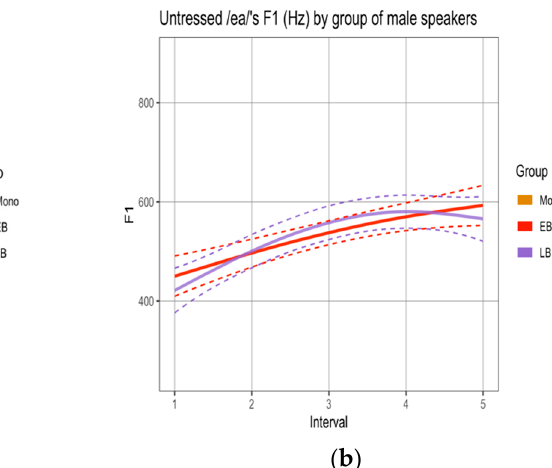
Figure A2. SSANOVAs for female fromant trajectories across five intervals within the sequences ( a ) /ae/ (F2); ( b ) /ea/ (F1); ( c ) /ea/ (F2); ( d ) /oe/ (F1); and ( e ) /oe/ (F2) produced by each group of speakers (M, EB, LB) in the narrative task.